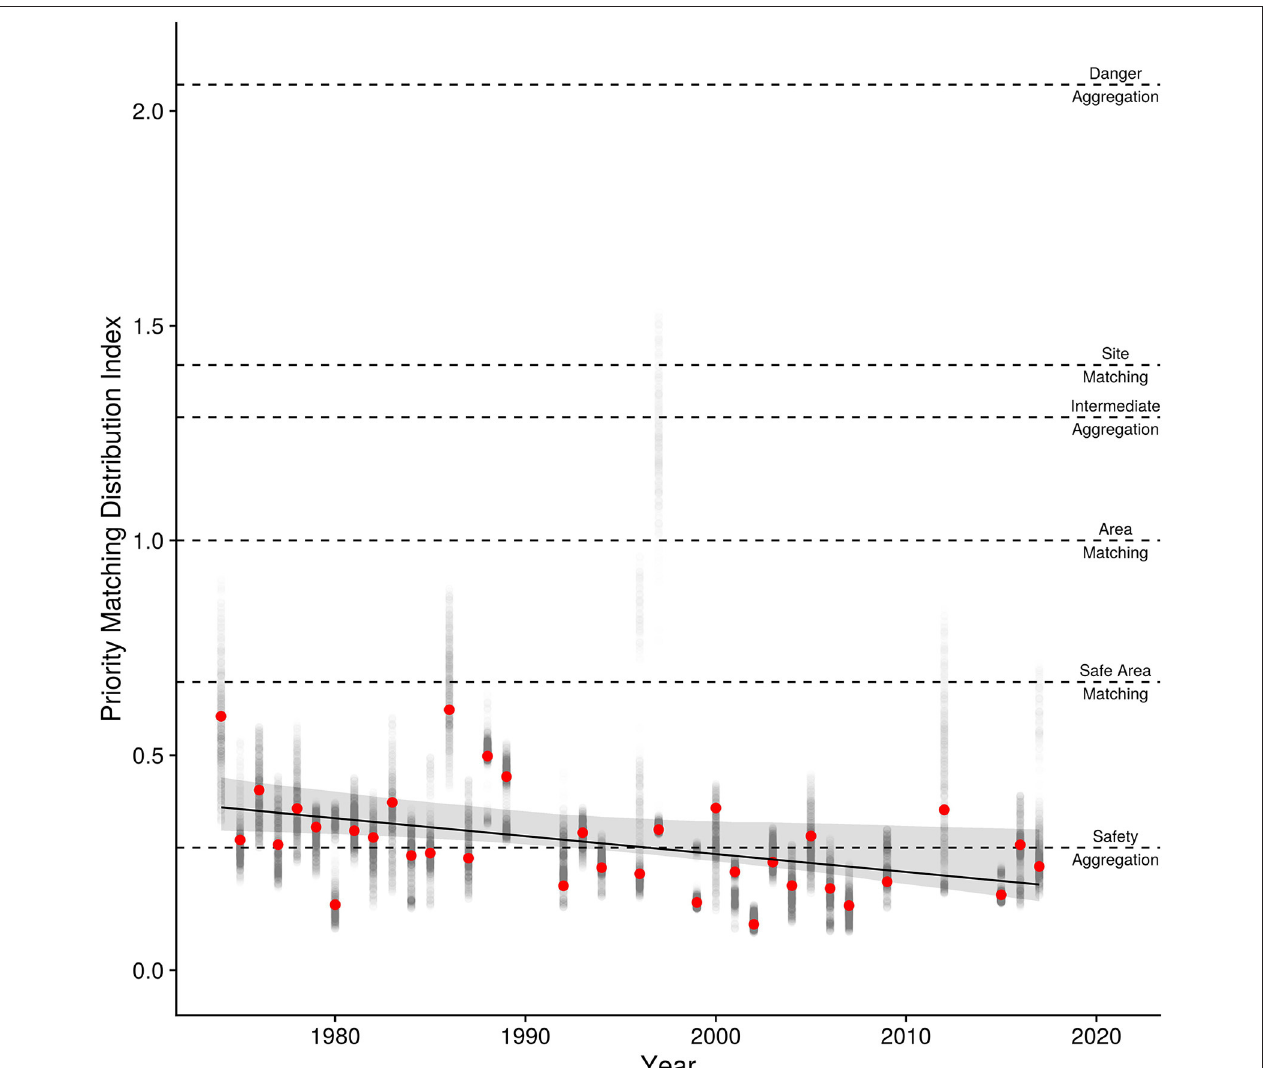
FIGURE 8 | Interannual trend in the Priority Matching Distribution index (PMD) with the 95% bootstrapped confidence intervals. Points are the PMD for each year (red points) with the 95th inner quantiles of variation in the estimate shown in the gray points. The expected PMD index values for various distributions (danger aggregation, site-matching, area-matching, safe-area-matching, and safety aggregation) are shown as horizontally dashed